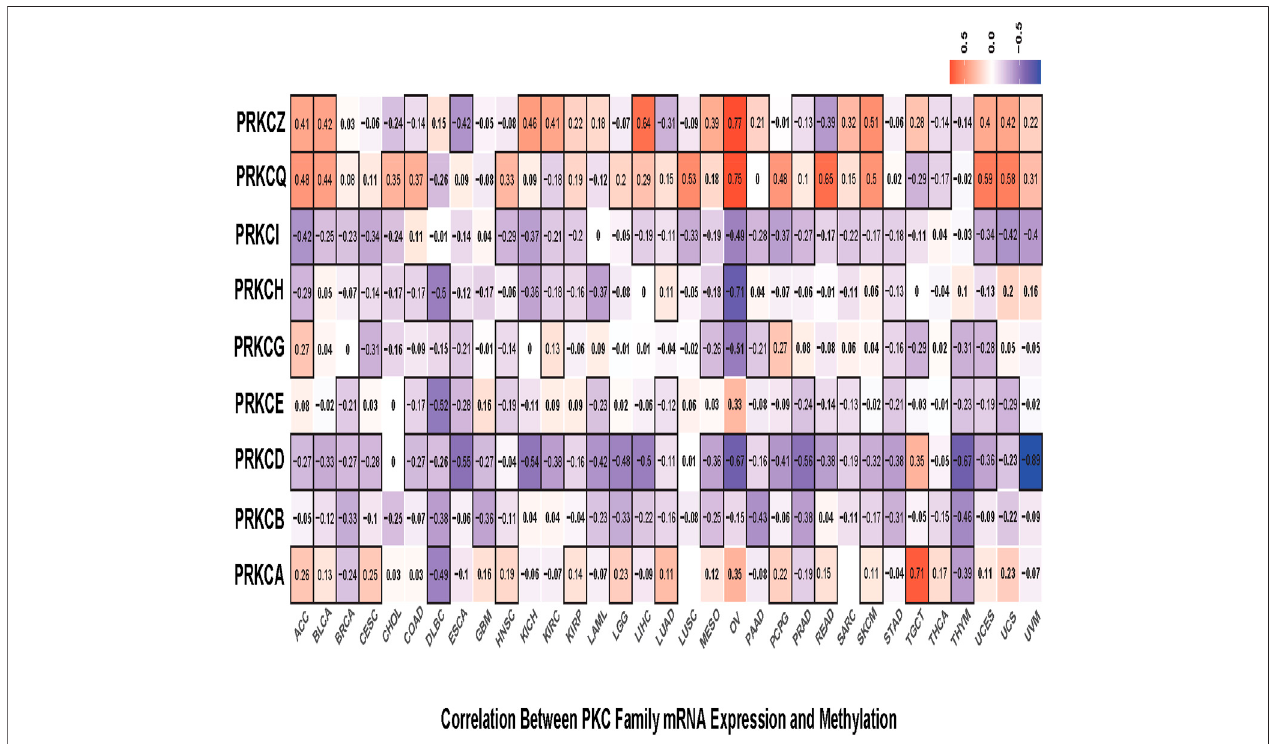
FIGURE 3 | Correlation heatmap between mRNA expression and methylation level of each PKC gene in all TCGA cancers, the color refers to correlation coef fi cients; the black border refers to the statistically signi fi cant correlation ( p -value < 0.05).